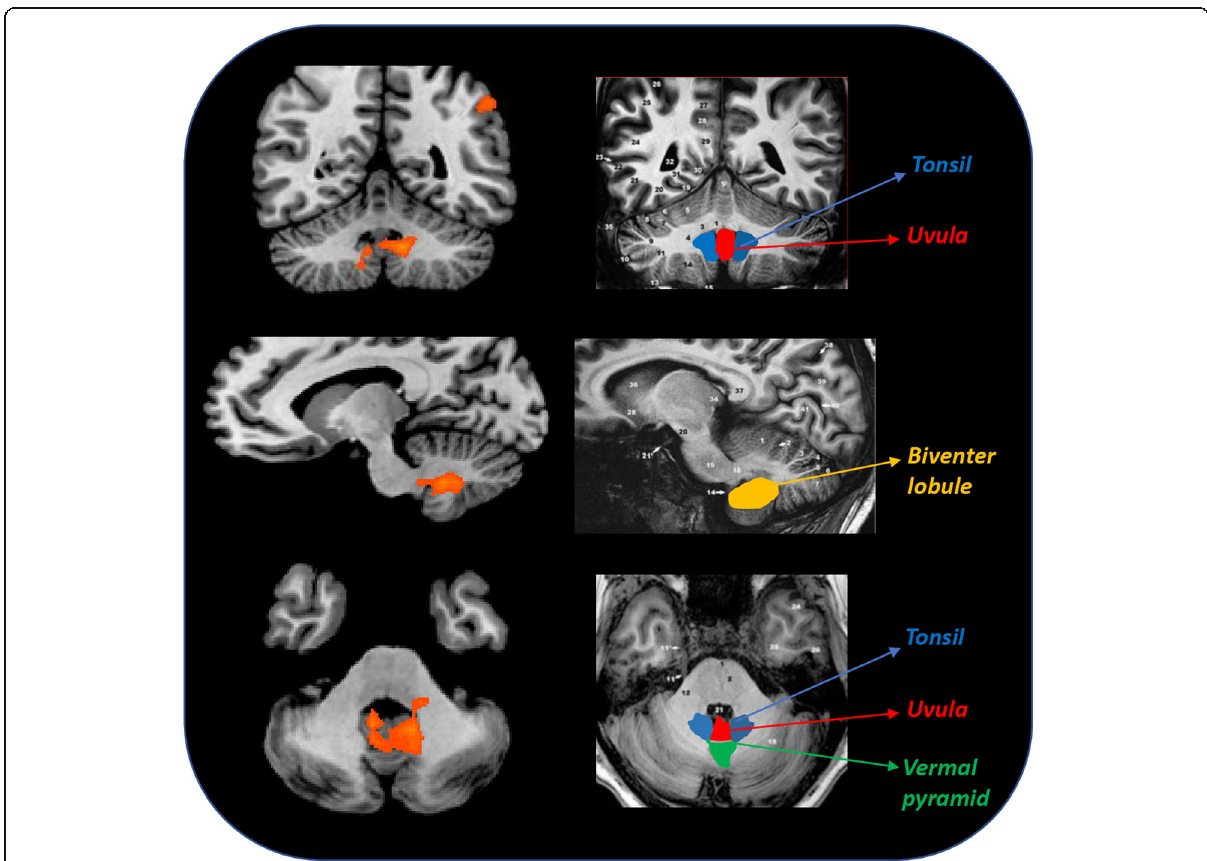
Fig. 4 Correspondence of function and structure of midline and lower structures of the cerebellum showing interictal increased response to THS in MwA patients. The coloured areas highlight the uvula, the tonsils and the biventer lobule. (adapted from Duvernoy HM, 1995). THS: trigeminal heat stimulation; MwA = migraine with